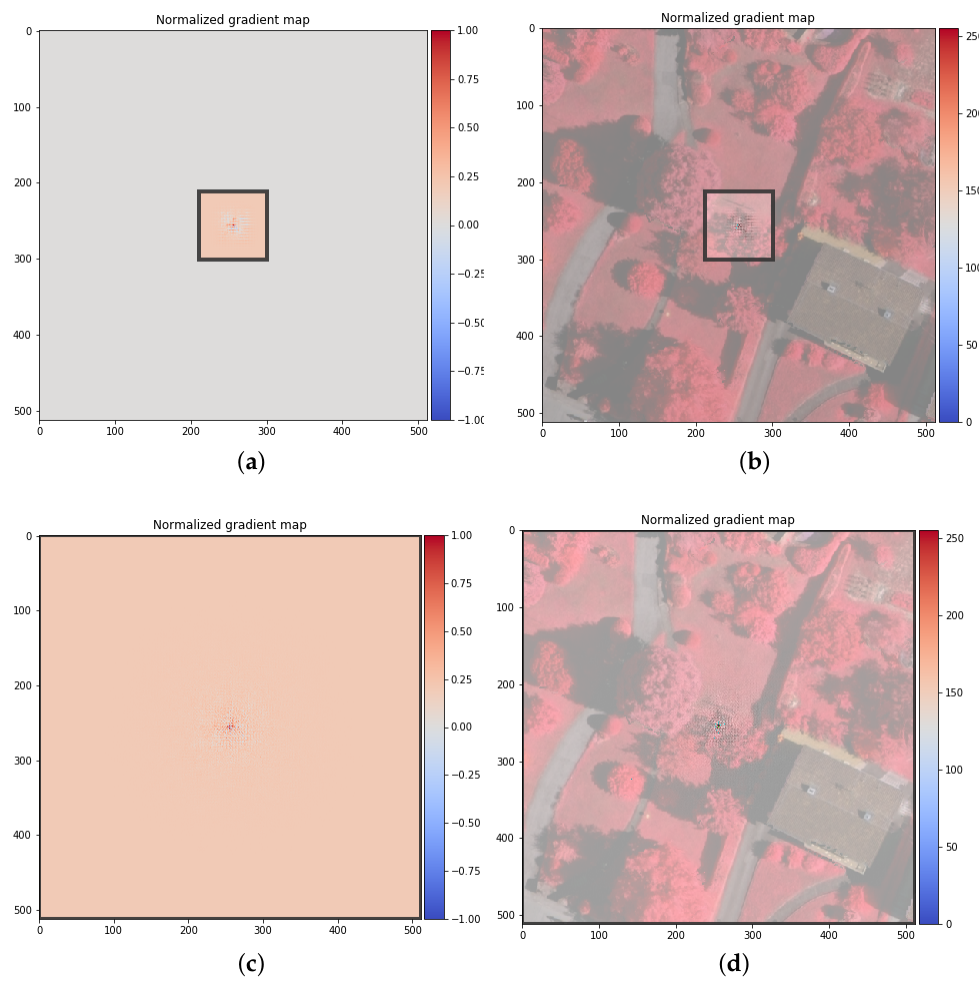
Figure 12. Receptive fields of the center pixel in SDFCNv1 and SDFCNv2 models. The black rectangular frames denote the theoretical regions of receptive fields. ( a ) RF of SDFCNv1; ( b ) RF of SDFCNv1 with image; ( c ) RF of SDFCNv2; ( d ) RF of SDFCNv2 with